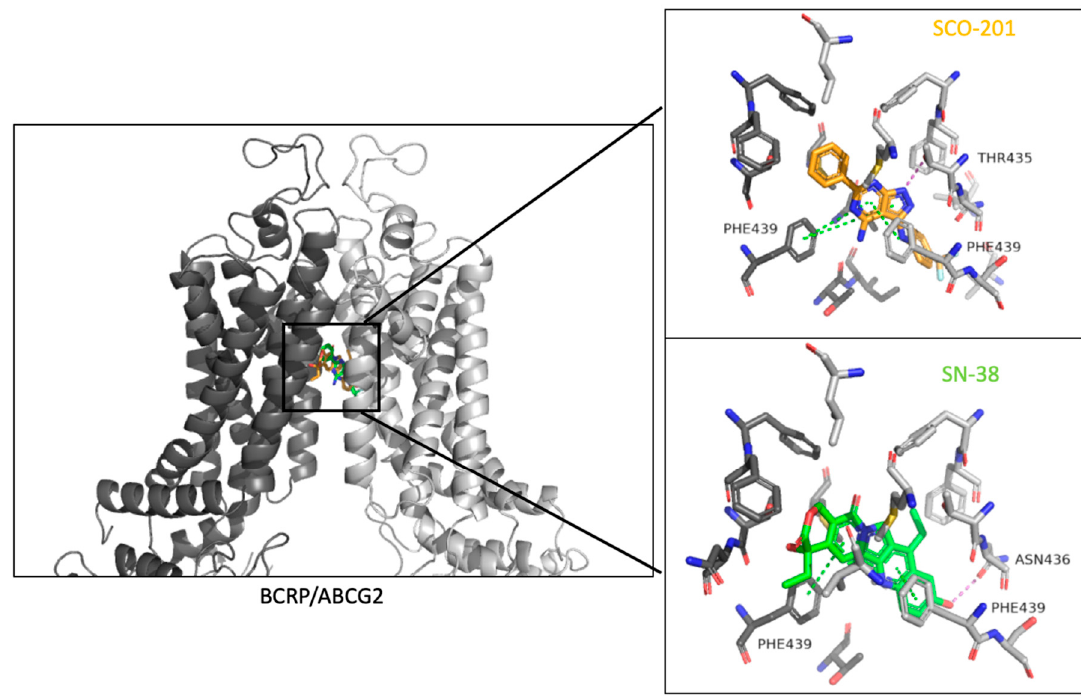
Figure 6. Docking of SN-38 and SCO-201 in the human BCRP transporter. The transporter is a homomeric dimer with chain A (dark grey) and chain B (light grey). SN-38 (green) and SCO-201 (orange) bind in the same binding cavity when docked using Glide, Schrödinger, 2019-3, LLC [39–41]. Both the substrate SN-38 and the proposed inhibitor SCO-201 interacted with Phenylalanine (PHE)-439 in both chains of the protein through hydrophobic Pi-stacking interactions. SCO-201 formed a hydrogen bond to Threonine (THR)-435, whereas SN-38 formed a hydrogen bond to Aspargine (ASN)-436. Pi-stacking interactions are colored green and hydrogen bonds are colored violet.